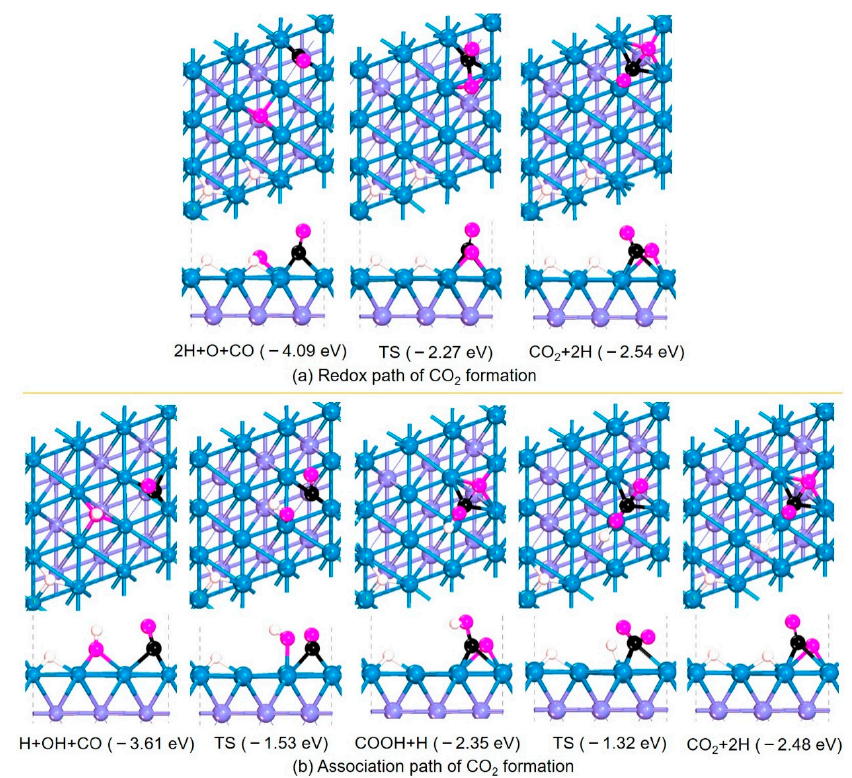
Figure 2. Structures and energies of CO 2 formation process on Fe